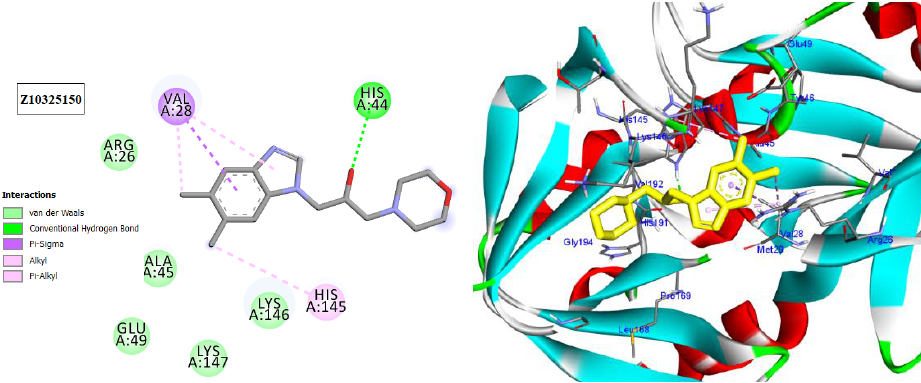
Figure 9. Two-dimensional and three-dimensional images of 13,17-dimethyltritriacontane docked into the HAV 3C protease enzyme binding site.